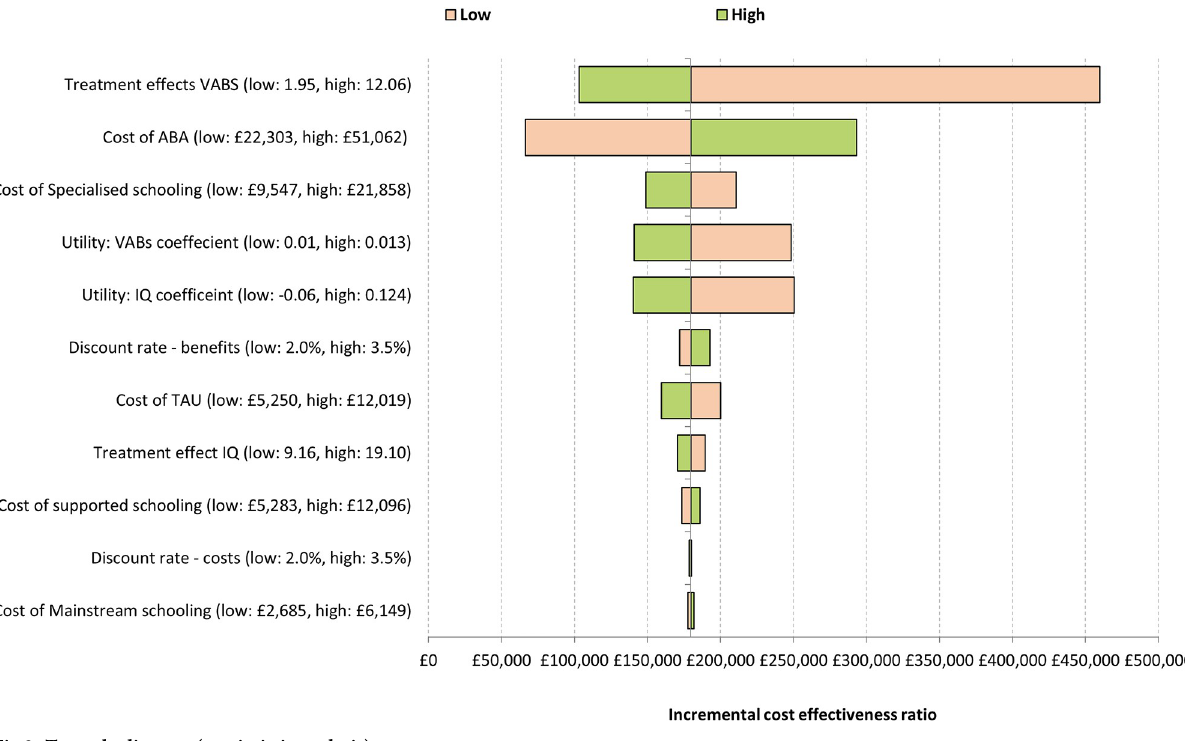
Fig 2. Tornado diagram (pessimistic